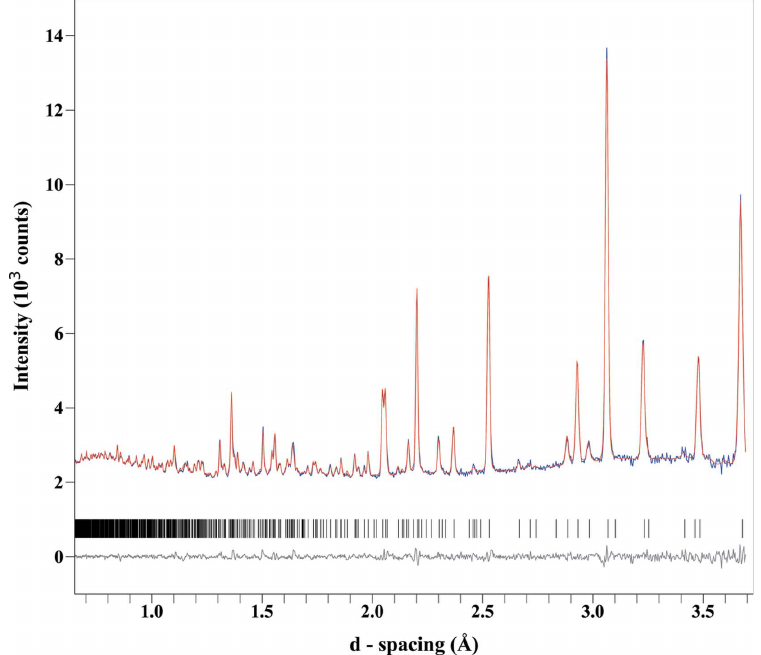
Figure 3 Observed (blue), calculated (red) and difference (grey) profiles after refinement of the NPD data for metatorbernite. Tick marks representing allowed reflections are shown in